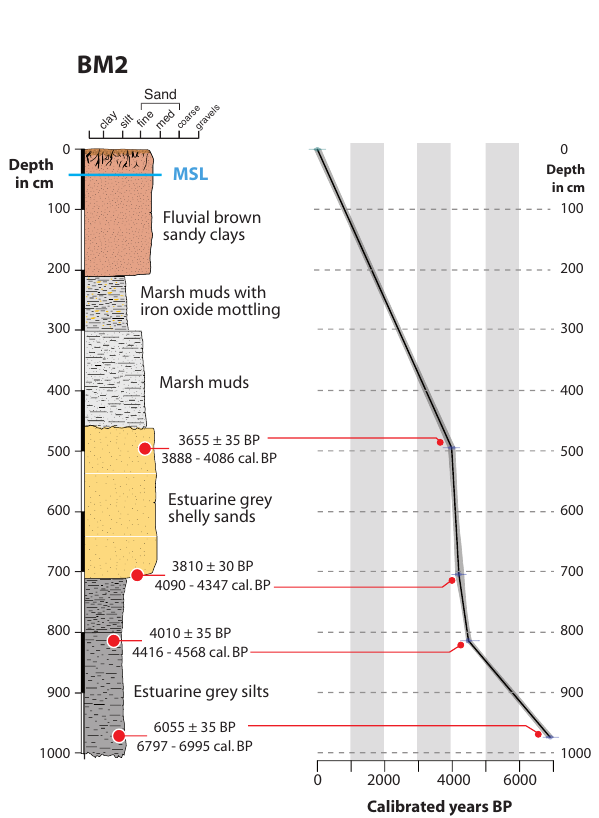
Figure 2. BM2 sedimentary profile and age–depth model interpo- lated